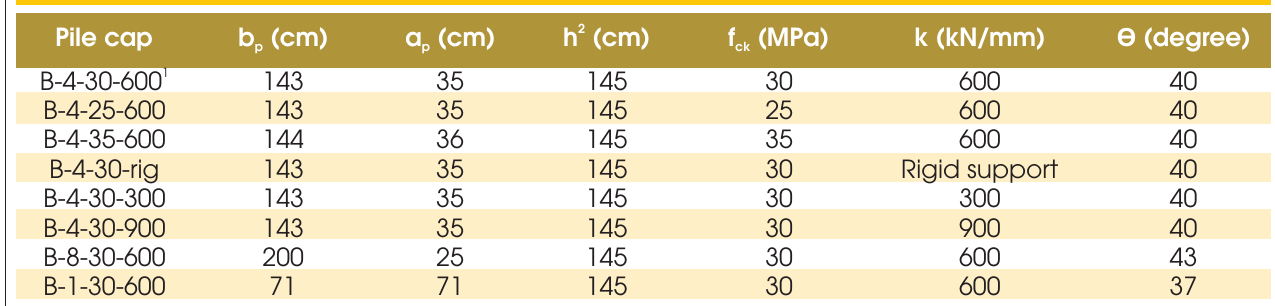
Table 1 – Parameters evaluated on six pile caps